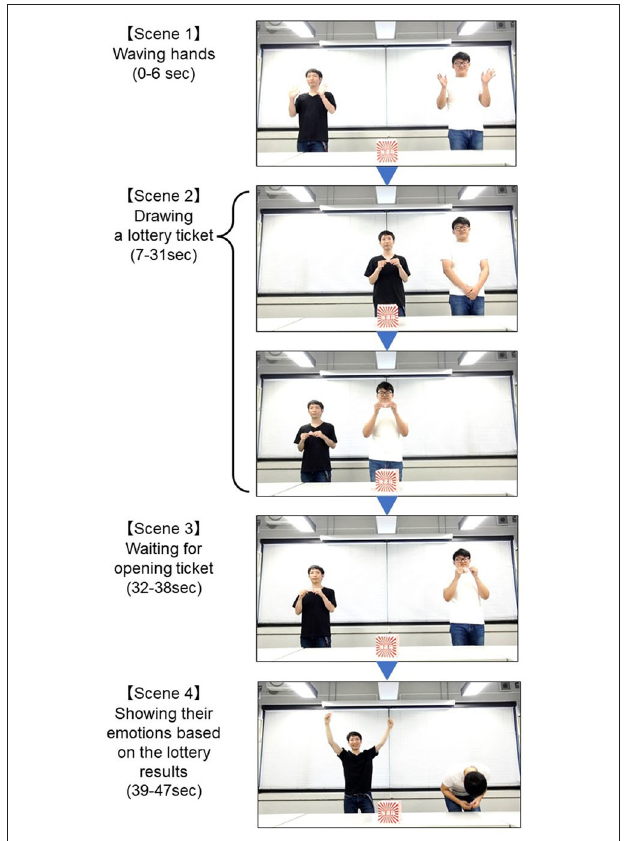
FIGURE 1 | This video had four scenes. In scene 1, the man wearing a black T-shirt (BM) and the man wearing a white T-shirt (WM) waved their hands at the camera ( ∼ 6s). In scene 2, BM moved to the lottery box at the center and selected one of the tickets. BM raised it in front of his chest and returned to his original position after a few seconds. Next, WM also moved to the lottery box at the center and selected one of the tickets. WM also raised it in front of his chest and returned to his original position after a few seconds ( ∼ 31s). In scene 3, BM and WN had the ticket in front of their face for 5s and then opened the ticket ( ∼ 38s). In scene 4, one drew the winning ticket and exhibited a happy face, while the other drew the losing ticket and exhibited disappointment ( ∼ 47s) (the winner was counterbalanced across